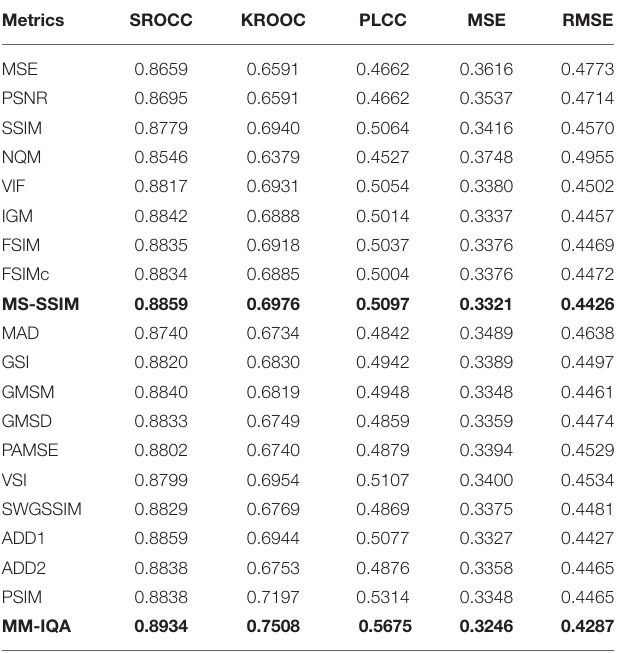
TABLE 2 | Performance comparison of FR-IQA metrics on the pool image database.